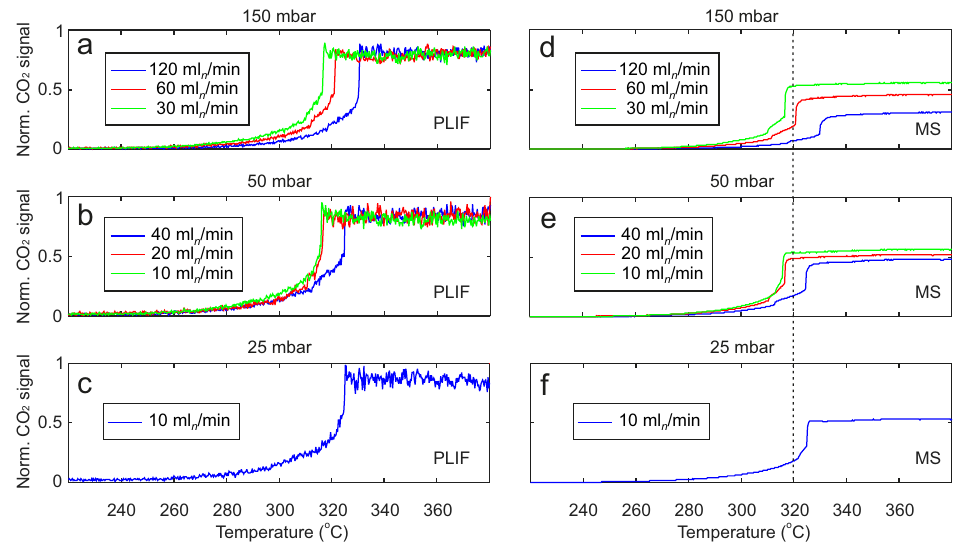
Figure 2. The CO 2 signals (here normalized to the initial CO partial pressures for comparison) measured by ( a ) PLIF at 150 mbar; ( b ) PLIF at 50 mbar; ( c ) PLIF at 25 mbar; ( d ) MS at 150 mbar; ( e ) MS at 50 mbar; ( f ) MS at 25 mbar. For 150 and 50 mbar pressures, three different flow rates are shown for comparison, while for 25 mbar only one flow rate is shown. All reactions are performed using 1:1 ratio of CO and O 2 and the same temperature ramp-up speed. A 4:4:92 ratio of CO, O 2 and Ar is used in 150 mbar with total flow of 120, 60 and 30 mL n /min, and in 50 mbar with total flow of 40 and 20 mL n /min. A 5:5:90 ratio of CO, O 2 and Ar is used in 50 mbar with total flow of 10 mL n /min, and in 25 mbar with total flow of 10 mL n /min. The dashed line is for guidance in temperature reading.